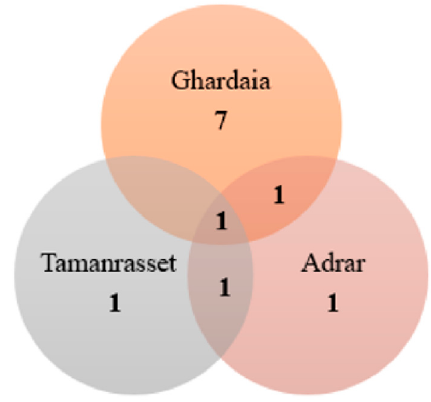
Figure 5. Venn diagram showing the numbers of shared and unique rare actinobacterial genera among the three most dominant Saharan soil samples sites.